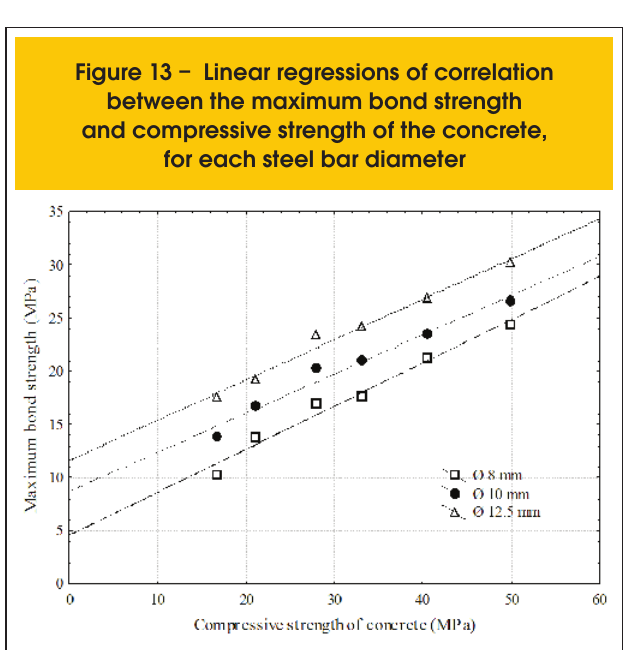
Figure 12 – Analysis of variance performed on test results obtained with the POT test. Influences of the diameter of the steel bars, concrete compositions and rupture age